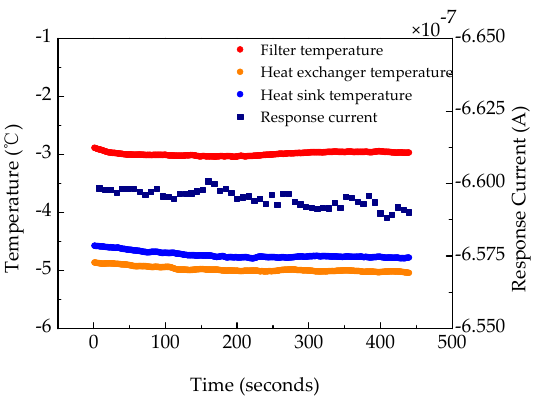
Figure 12. Results of the detector ‐ level bench stability experiment. The response current fluctuation was approximately 0.19% during the experiment, and the temperature fluctuations of the filter, heat sink, and heat exchanger were less than 0.02 °C.